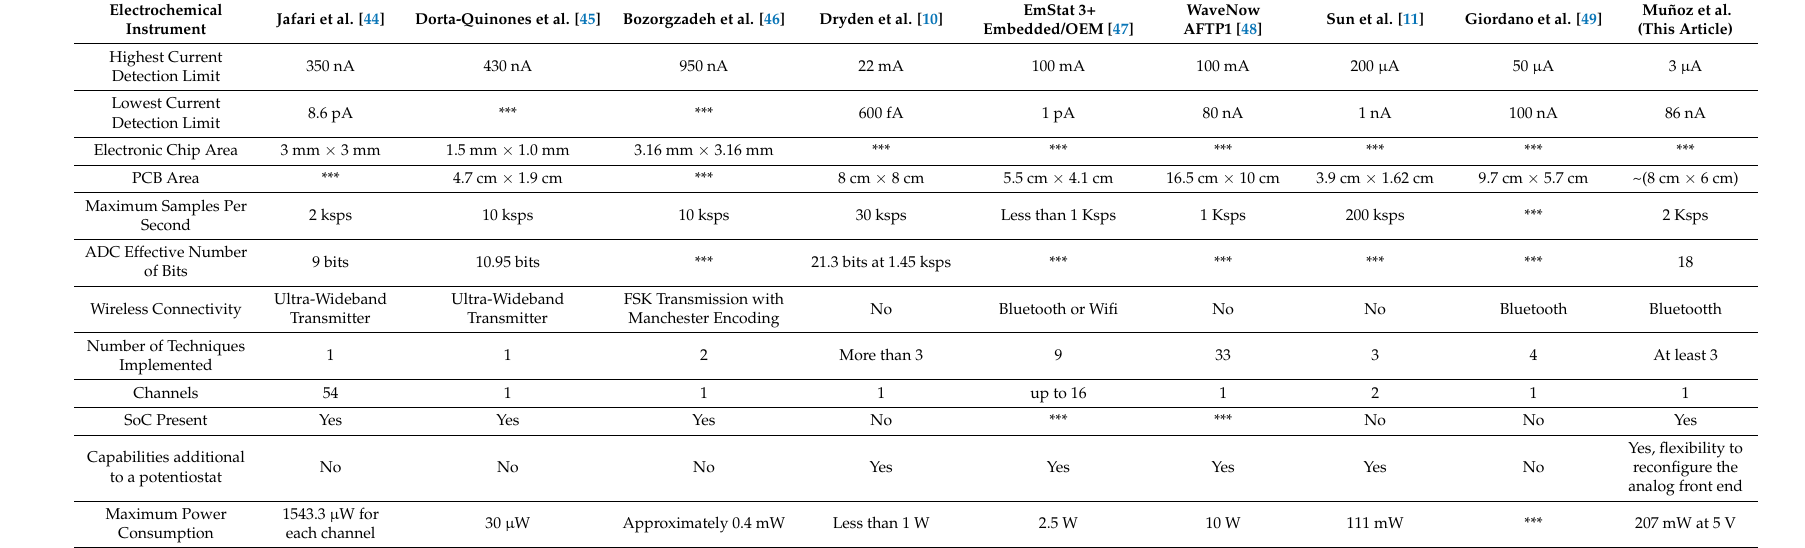
Table 13. Electrochemical Instruments Comparison. *** Data not